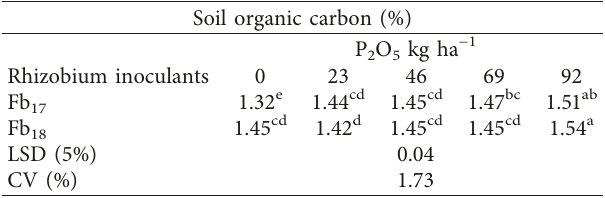
Table 7: Effect of rhizobium strain and P fertilizer on exchangeable acidity and basic cations.